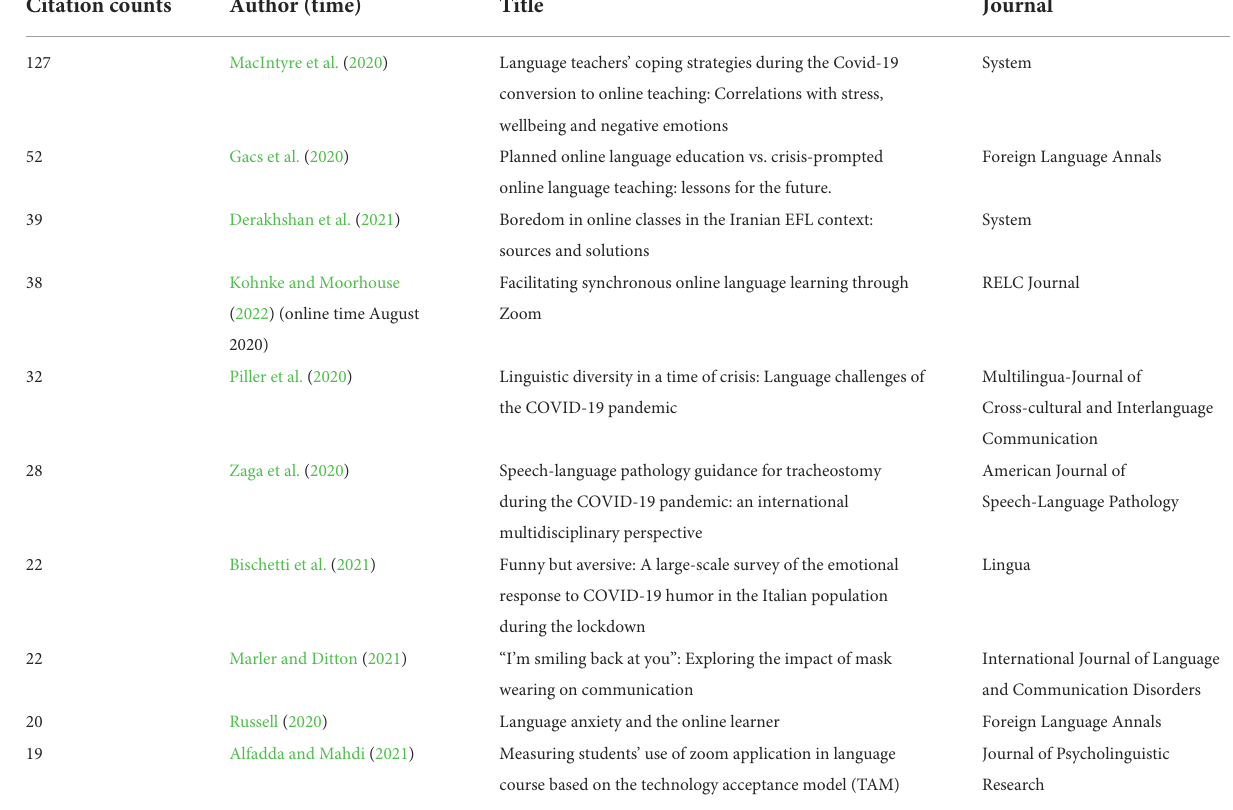
TABLE 4 Top 10 most-cited articles contributing to COVID-19 linguistic